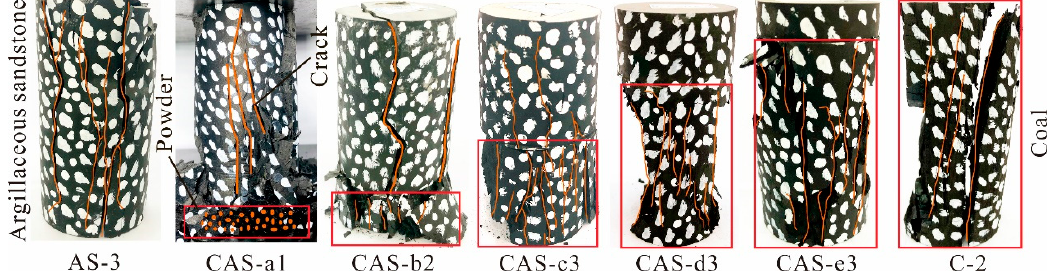
Figure 9. Final failure pattern of partial combination specimen.